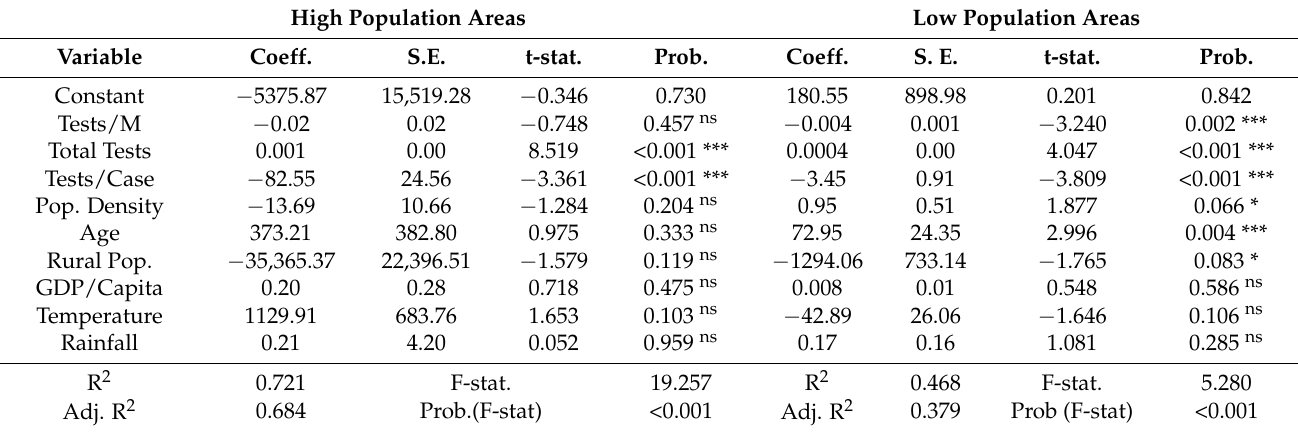
Table 6. Result of OLS regression analysis on factors affecting number of deaths of COVID-19. High Population Areas Low Population